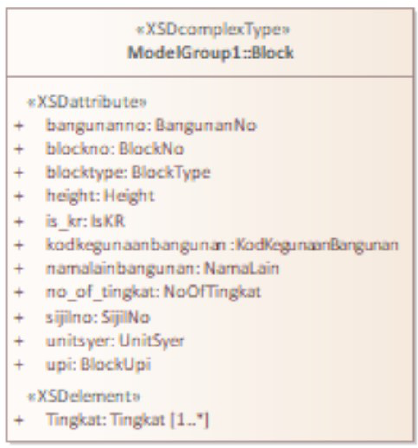
Figure 3 .The strata XML Block attributes.